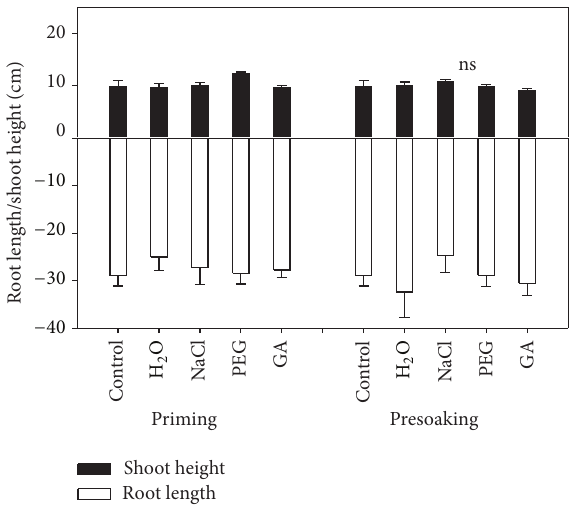
Figure 4: Effects of pretreatment reagents and priming methods on seedling shoot height and root length of maize ( 𝑛 = 10 ; ns: not significant).